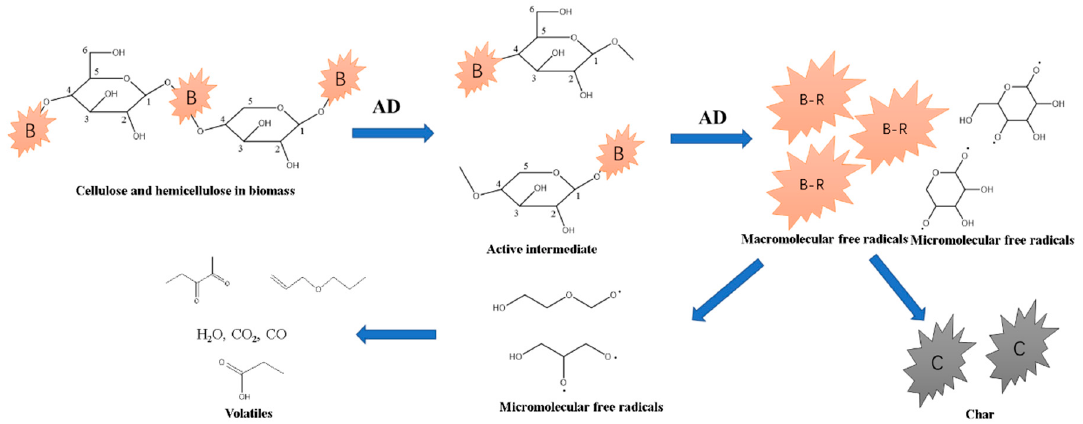
Figure 9. Scheme 1 for formation of ketones from cellulose and hemicellulose catalyzed by AD.